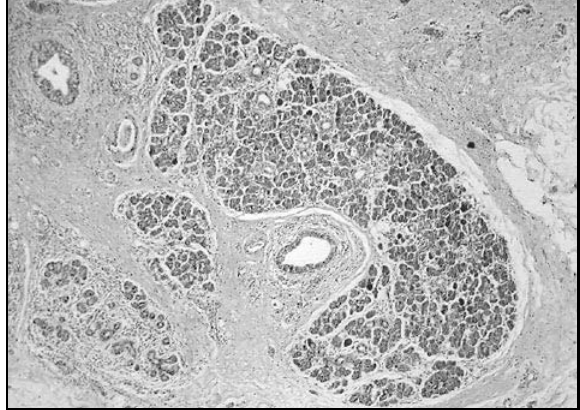
Figura 4 – Substituição do parênquima glandular por intensa